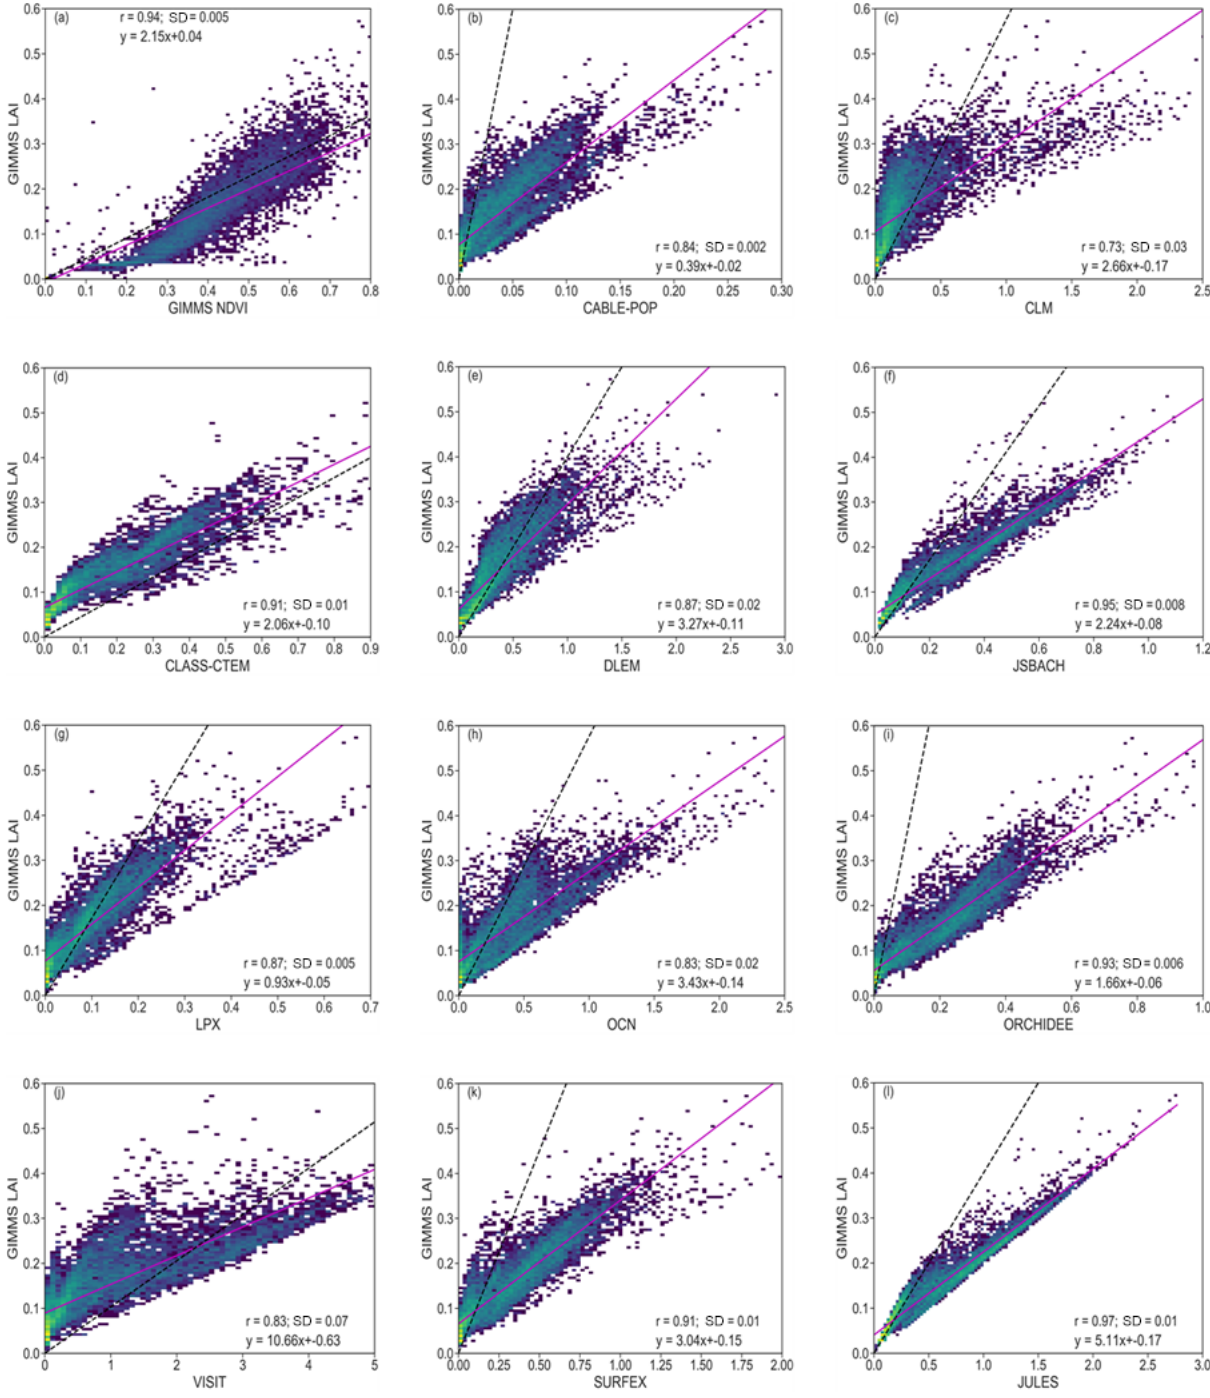
Figure 2. Scatterplots of correlations between vegetation indices (observation and model) for the period 1982–2011 over southern Africa. Inset values indicate the correlation coefficient ( r ) and standard deviation (SD) between GIMMS LAI and GIMMS NDVI, as well as GIMMS LAI and modelled LAI. The colour represents each grid cell. The pink solid line is the linear regression, while the dashed black line shows the 1 : 1 line. The unequal x axes are to visualize the detailed data for the